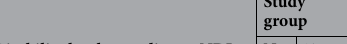
Disability level according to NDI No disability (up to 20%)